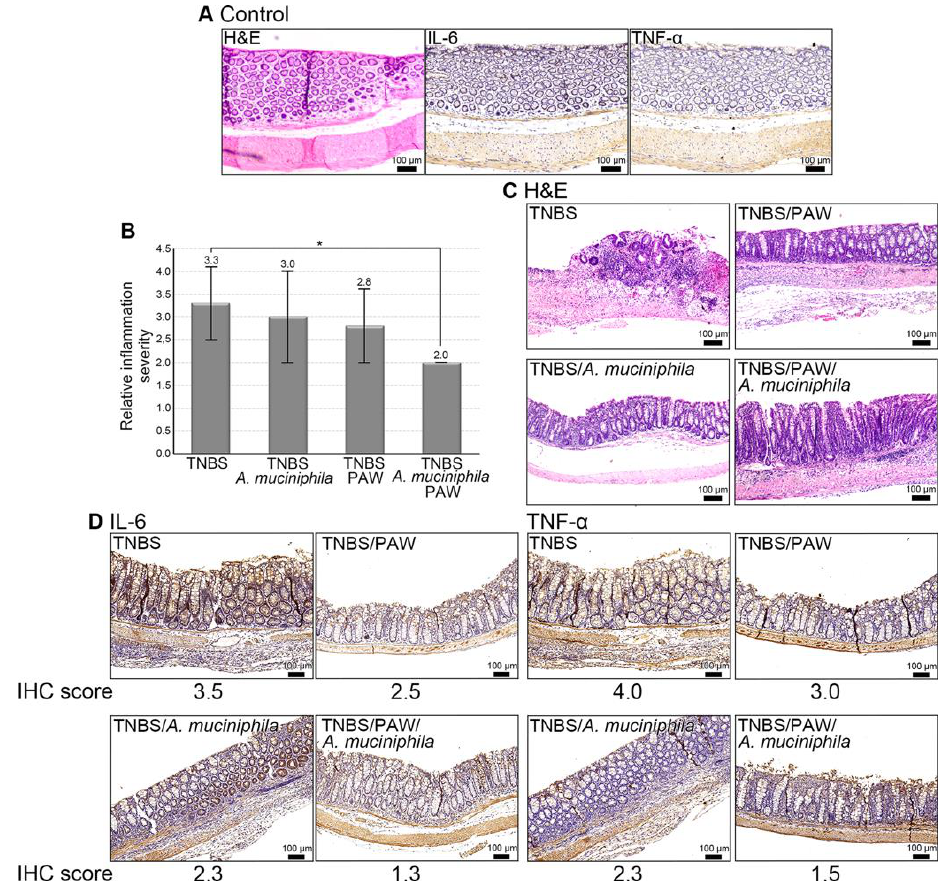
Figure 7. Change of inflammatory response in the presence of A . muciniphila . ( A ) Histological change and signal intensity of IL-6 and TNF- α in the control mice. Control mice, mice without PAW consumption and A . muciniphila treatment. ( B ) Histological score of inflammation in different groups. Score for inflammation severity: 1, none; 2, mild; 3, moderate; 4, severe. ( C ) Representative images of H&E-stained colon sections for inflammation severity. ( D ) Representative images of IHC staining for IL-6 and TNF- α in mouse colon. IHC score for the percentage of positively stained cells: 1, 0 – 25%; 2, 26 – 50%; 3, 51 – 75%; 4, 76 – 100%. TNBS, 2,4,6-trinitrobenzene sulfonic acid; PAW, plasmon-activated water; H&E, hematoxylin, and eosin; IHC, immunohistochemistry. Scale bars, 100 μm. * p < 0.05.